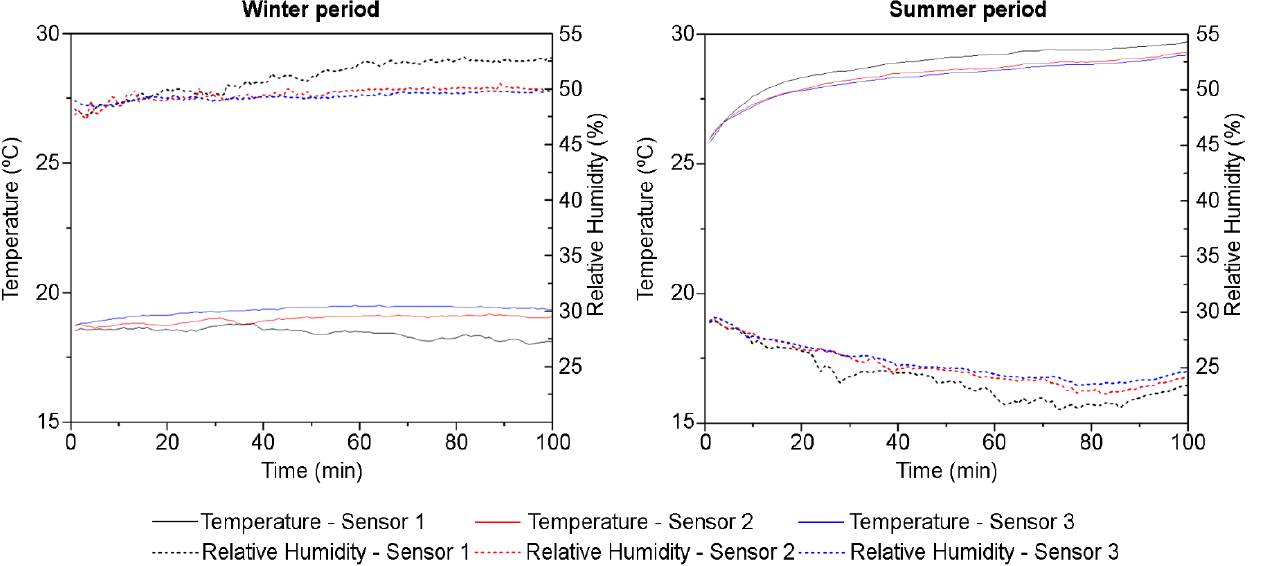
Figure 5. Temperature and humidity data obtained in both winter and summer assessment periods.